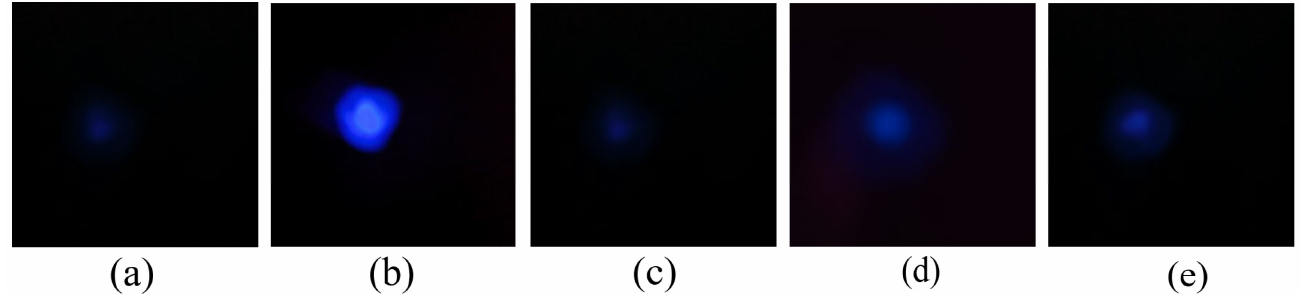
Figure 3. Comparison between five mobile phones. ( a ) Image captured by Xiaomi P30; ( b ) Image captured by Huawei P30; ( c ) Image captured by OPPO Reno8 Pro+; ( d ) Image captured by iPhone 13; ( e ) Image captured by Honor X20.